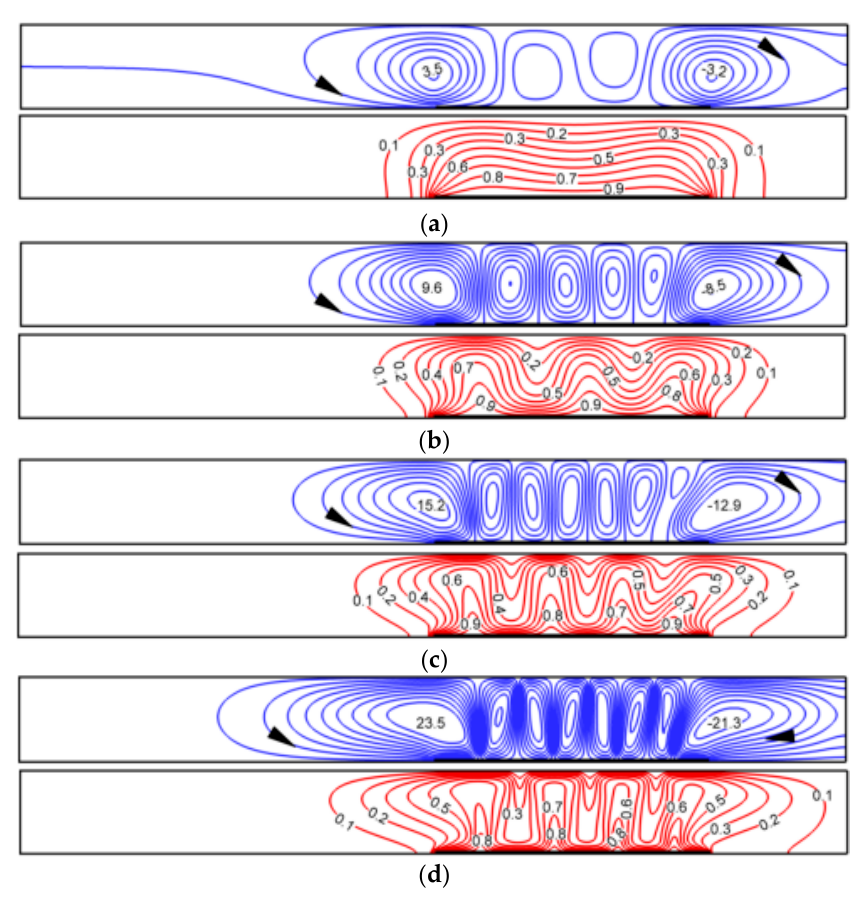
Figure 4. Streamlines (above) and isotherms (below) profiles for different Ra numbers and Pe = 0.5, ( c = 0.66), ( a ) Ra = 100, ( b ) Ra = 250, ( c ) Ra = 500, ( d ) Ra = 1000